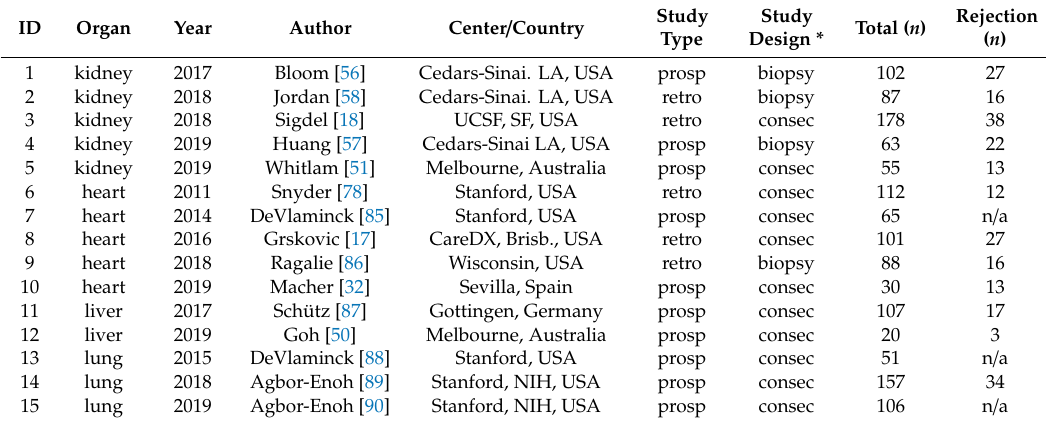
Table 2. Selected cohort studies focusing on the potential role of dd-cfDNA in SOT of various organs. ID Organ Year Author